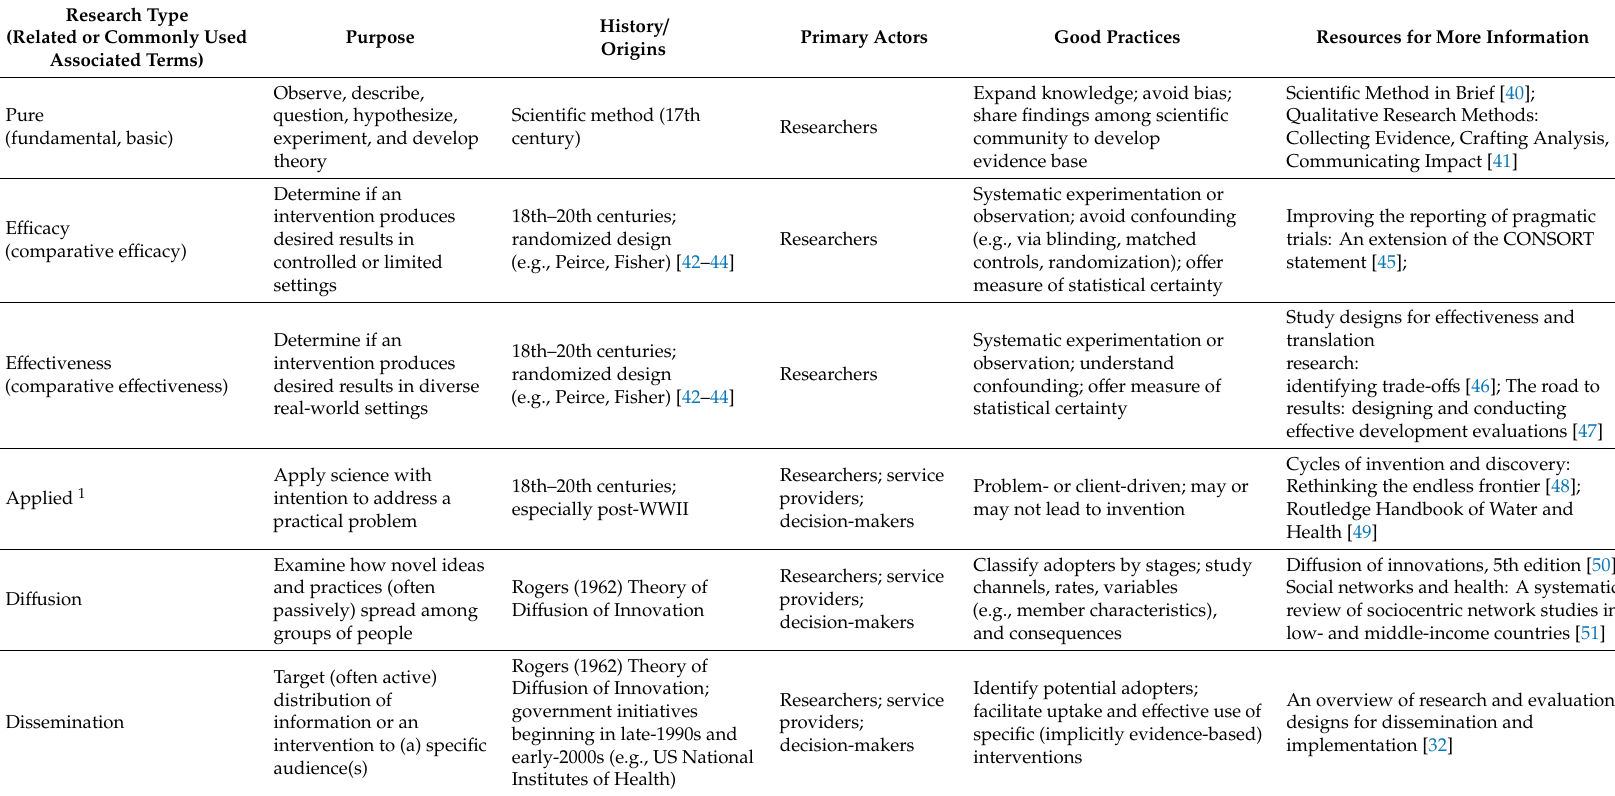
Table 2. Principal translational research types relevant to water, sanitation, and hygiene and their major